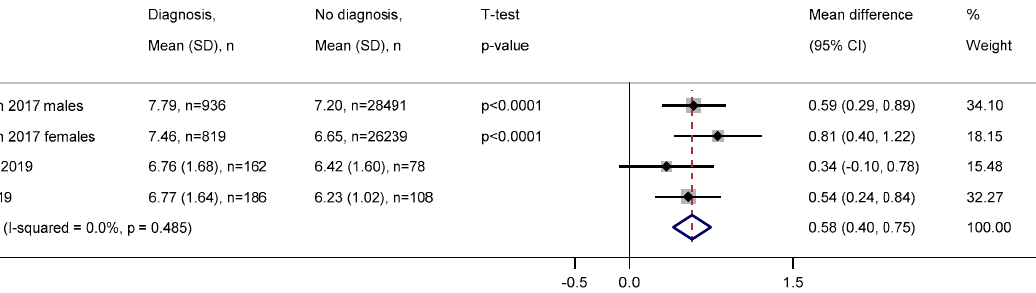
Figure 2. Forest plot of mean difference in white blood cell count between those with and without a diagnosis of colorectal cancer zero to six months later. Abbreviations: SD = standard deviation, CI = confidence interval. White blood cell measurements are in 10 9 /L.